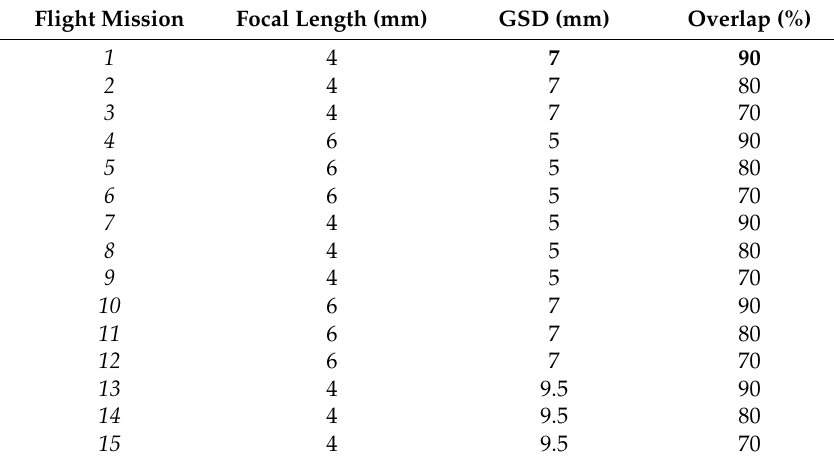
Table 1. Set of flight missions. GSD, ground sample